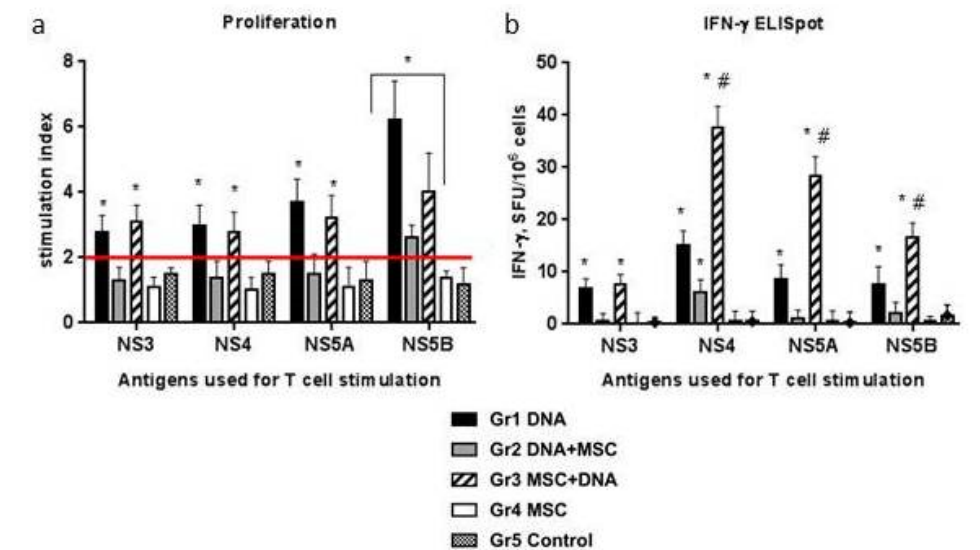
Figure 4. T-cell response of immunized mice to recombinant proteins from the nonstructural region of HCV. Each group (5 mice) received the DNA plasmid and/or naïve MSCs during two injections with a three-week interval. To assess the cellular response of lymphocytes in vitro, we used the recombinant proteins from the nonstructural region of HCV, which were combined into four pools (NS3, NS4, NS5A, and NS5B); the medium alone was used as the negative control. Results of T-cell proliferation are expressed as stimulation indexes (SIs) ( a ); the IFN- γ production by splenocytes in response to HCV proteins was expressed as the difference in the number of spots (spot-forming units, SFUs) per 10 6 cells between the wells stimulated by the nonstructural HCV antigens and the mean control wells without specific stimulators (growth medium alone) +2 standard deviations (SDs) ( b ). * p < 0.05 compared to the control (group 5); # p < 0.05 compared to all groups; red line—the threshold level of the reaction.